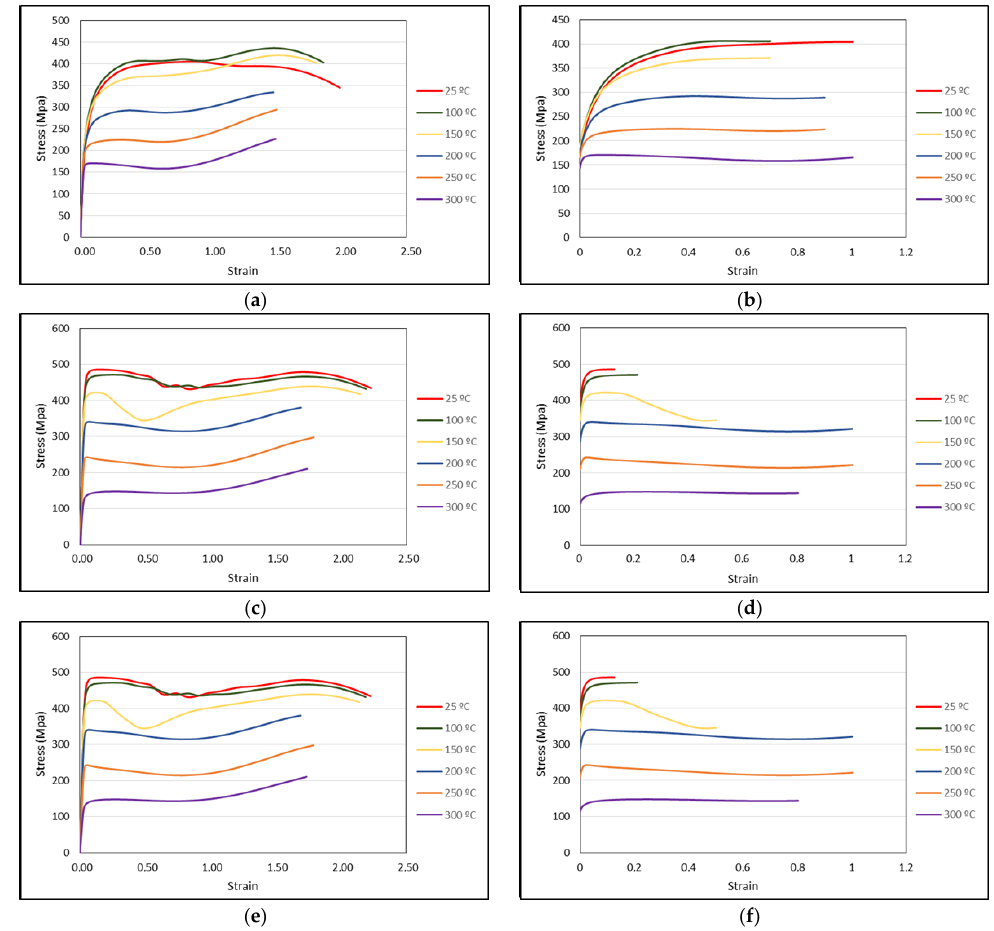
Figure 6. Complete flow rules experimentally obtained for AA5083 and their corresponding plastic zones selected for the development of the new flow rule: ( a ) complete flow curves for AA5083 at N0; ( b ) Selected zone for AA5083 at N0; ( c ) complete flow curves for AA5083 at N2; ( d ) selected zone for AA5083 at N2; ( e ) complete flow curves for AA5083 at N2 + flash; ( f ) selected zone for AA5083 at N2 +